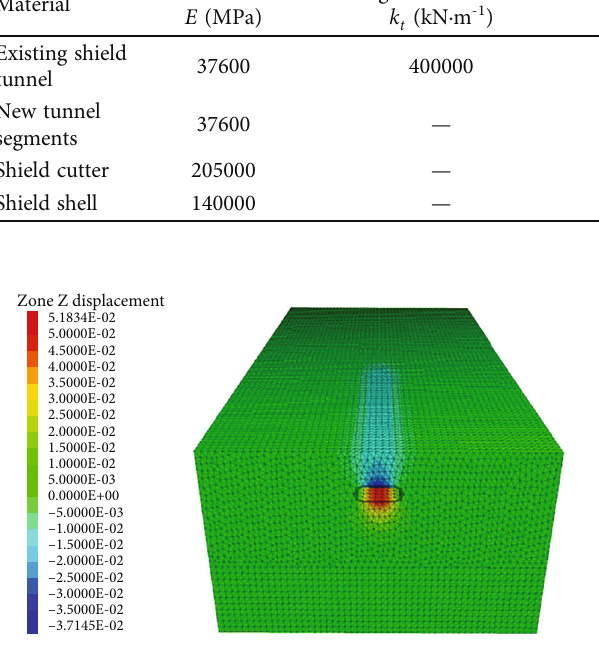
Figure 12: Ground surface subsidence cloud